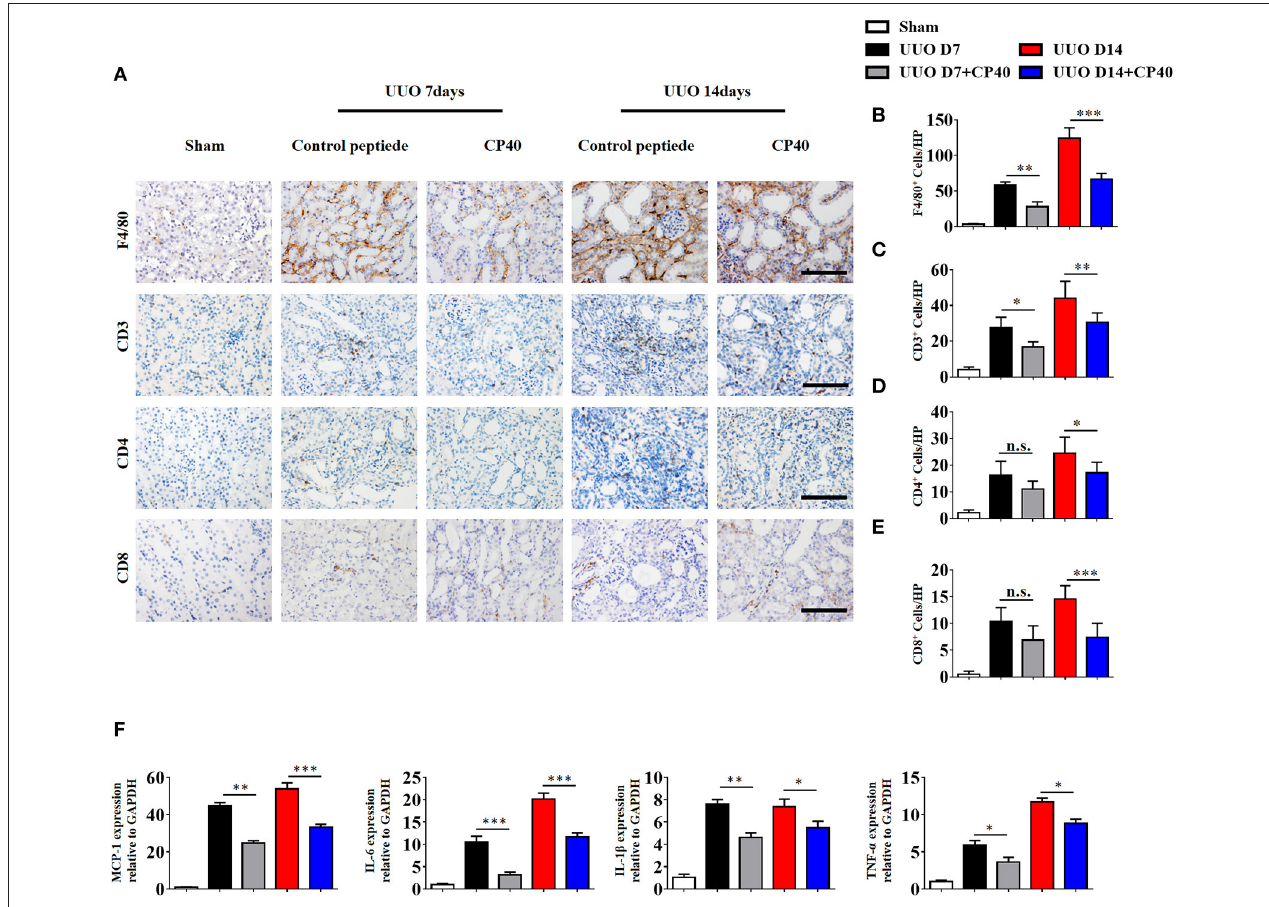
FIGURE 5 | C3 deficiency reduces C3 expression, inflammatory infiltration and fibrosis in kidney during UUO. UUO mice were subcutaneously injected with control peptide and Cp40. On days 7 and 14, mice were sacrificed, and the left kidneys were collected. (A) IHC staining showing F4/80 macrophages, CD3 + T cells, CD4 + T cells, and CD8 + T cells in these groups ( n = 6); original magnification, × 400. Scale bar, 50 µ m. Quantitative analysis of F4/80 (B) , CD3 (C) , CD4 (D), and CD8 (E) positive cells were shown as mean ± SEM. (F) Real-time PCR showing relative renal levels of MCP-1, IL-6, IL-1 β , and TNF- α in these groups ( n = 6). The error bars represent the SEM. * P < 0.05; ** P < 0.01; *** P <